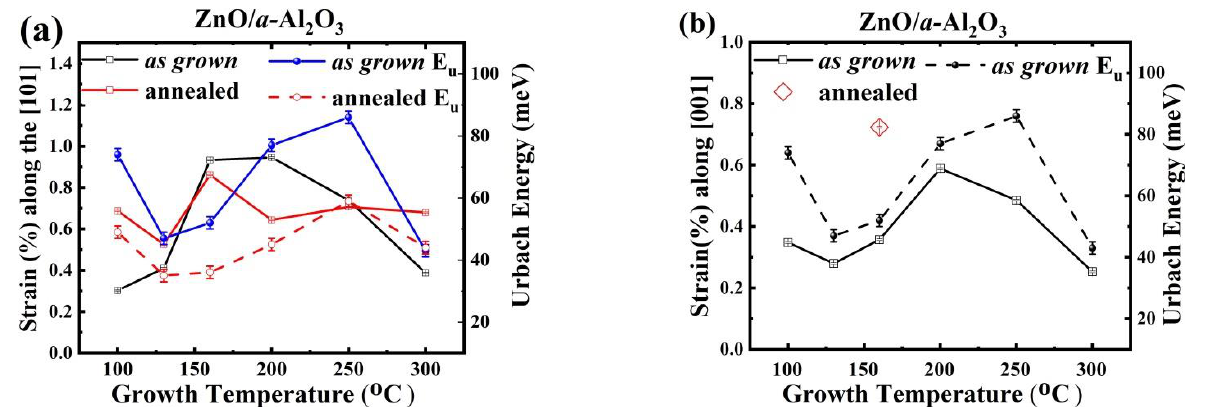
Figure 8. The values of strain (open squares) along ( a ) the [101] direction and ( b ) the [001] direction (along the c-axis) and their correlation with the Urbach energy (solid and open circles) in ZnO/a-Al 2 O 3 films.